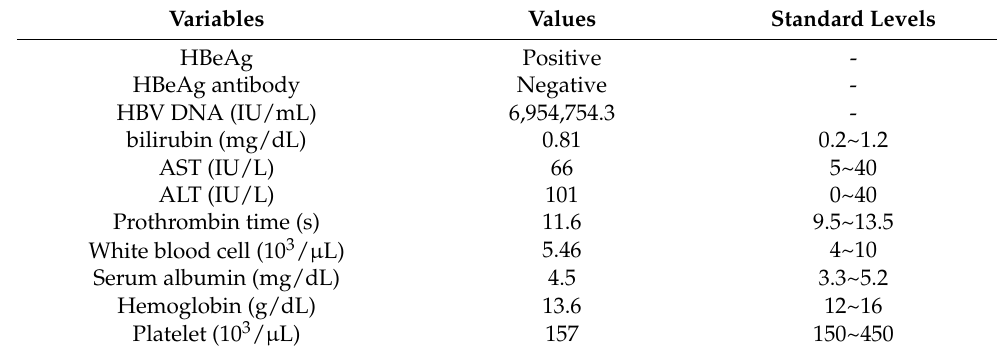
Table 1. Virological, serological, and biochemical characteristics of the study subject. Variables